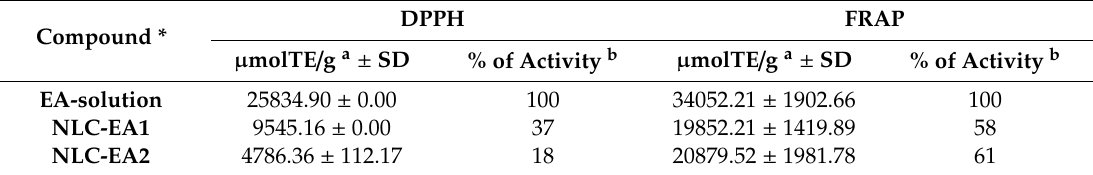
Table 5. Antioxidant activity of NLC-EA as determined by FRAP and DPPH